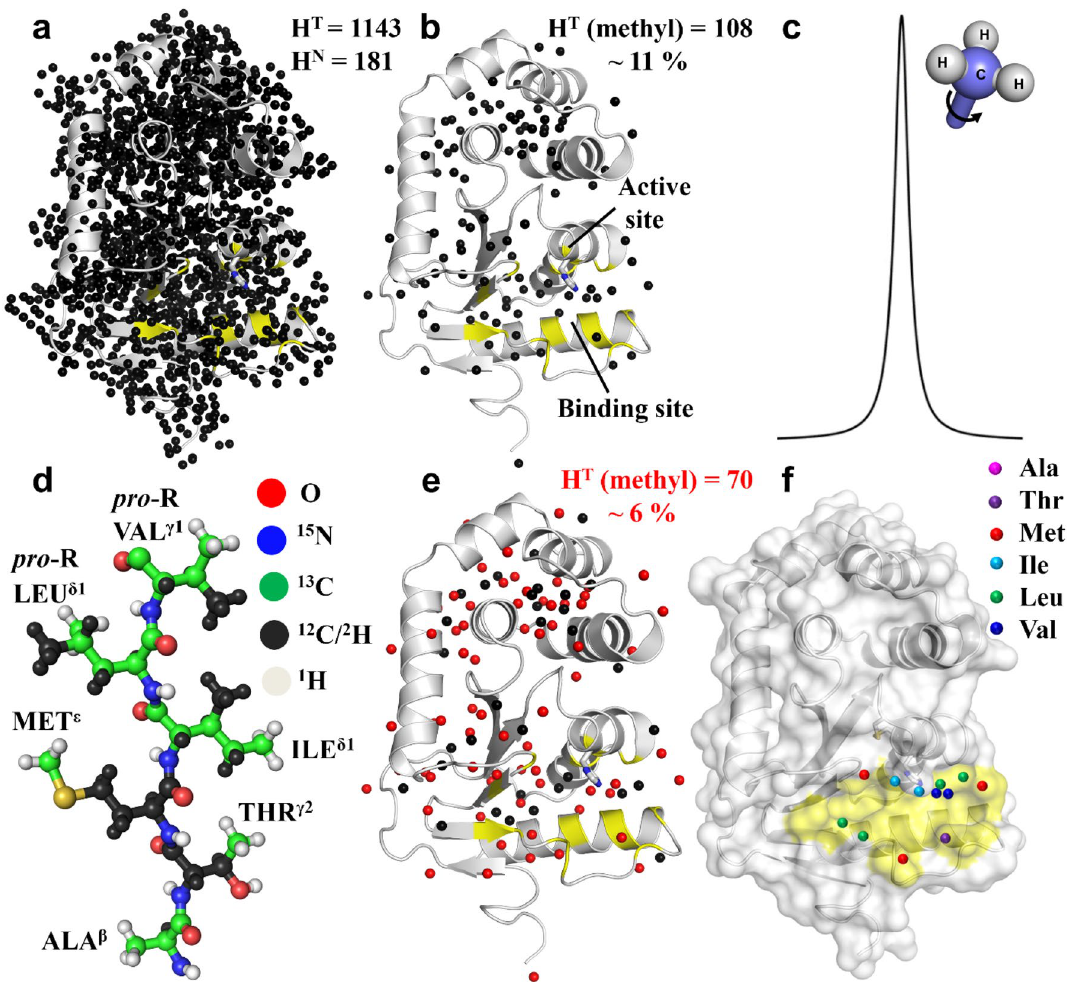
Figure 1. Labelling strategy used in the study. Schematic representation of the proton density in the structure of the bacterial oxidoreductase enzyme Ec DsbA, showing the position of amide (H N ) and total (H T ) protons ( a ) when fully protonated, ( b ) when fully deuterated except for methyl groups, which represent 11% of all protons. ( c ) Schematic showing that the fast rotation of methyl groups results in narrow linewidths in NMR spectra. ( d,e ) Labelling scheme used in the triple labelled sample where only one methyl group is protonated in Ile, Leu and Val, decreasing the proton density to 6% versus the fully protonated protein. ( e,f ) Residues that form the ligand binding site in Ec DsbA are colored yellow and the positions of methyl-containing residues adjacent to the binding site are highlighted. H T indicates total number of proton resonances expected in the NMR spectrum of oxidized Ec DsbA (PDB ID: 1FVK). Total number of expected proton resonances was calculated assuming methyl/methylene/symmetric aromatic protons had the same chemical shift. Analysis was done by